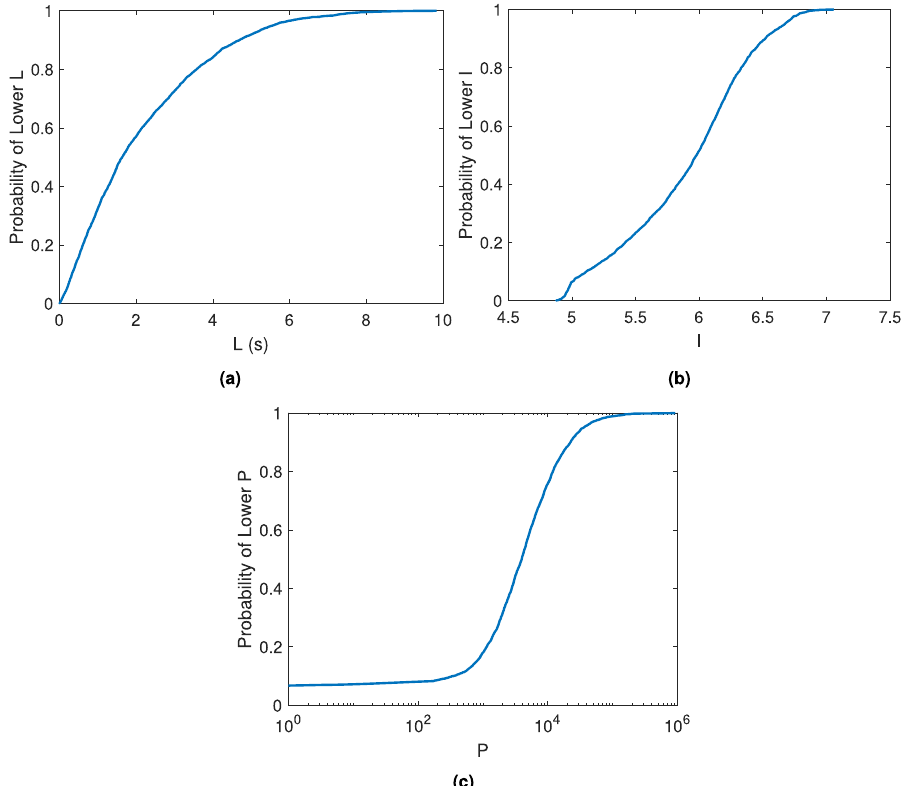
Fig. 8 Deriving the EEW relative feasibility index. Empirical cumulative distribution functions of a median lead time ( L ), b average seismic intensity ( I ), and c ambient population ( P